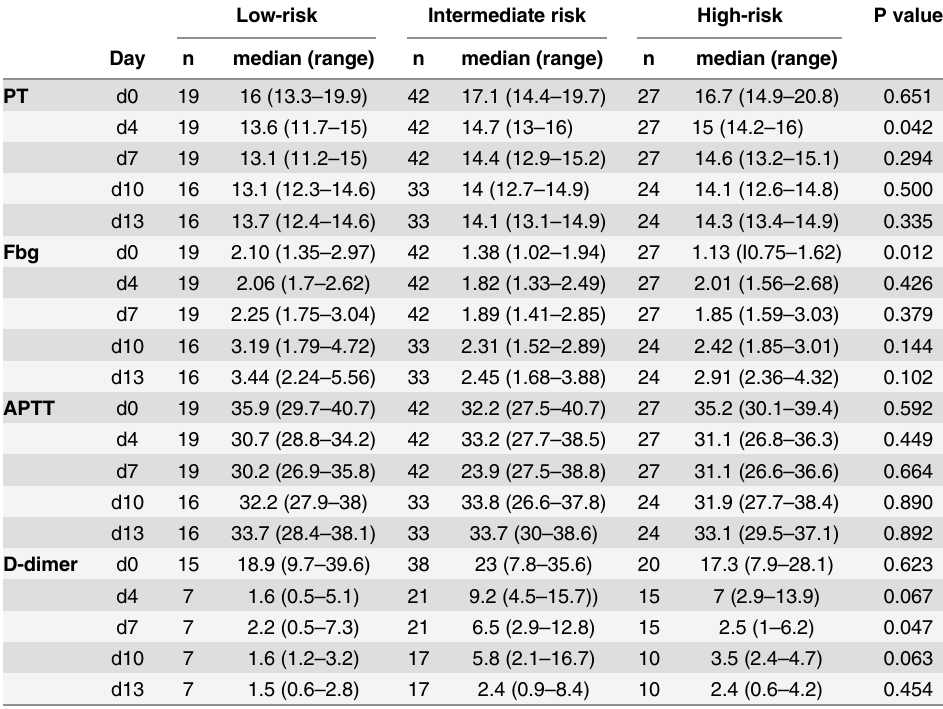
Table 4. Change in the trend of hemostatic parameters in APL patients with different prognostic stratification.